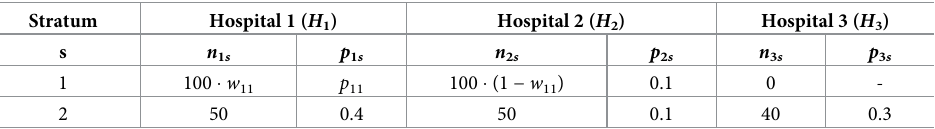
Table 7. Example of variations in actual mortality rates under internal standardization: Parameter